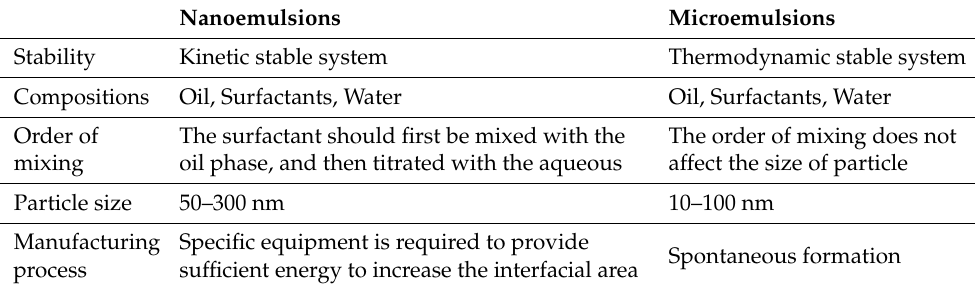
Table 4. The comparison of nanoemulsions and microemulsions